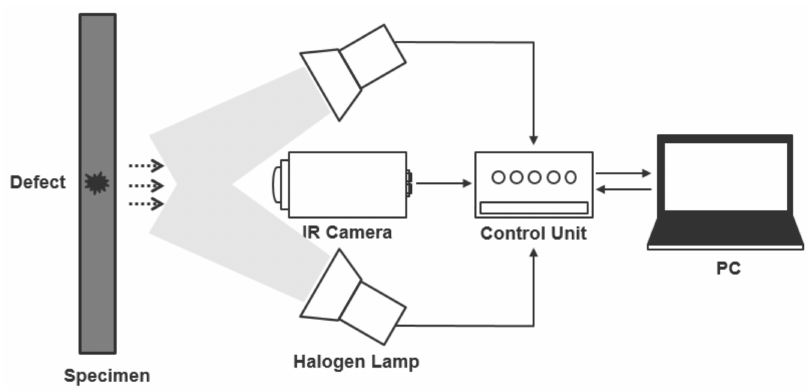
Figure 4. Experimental configuration of lock-in infrared thermography